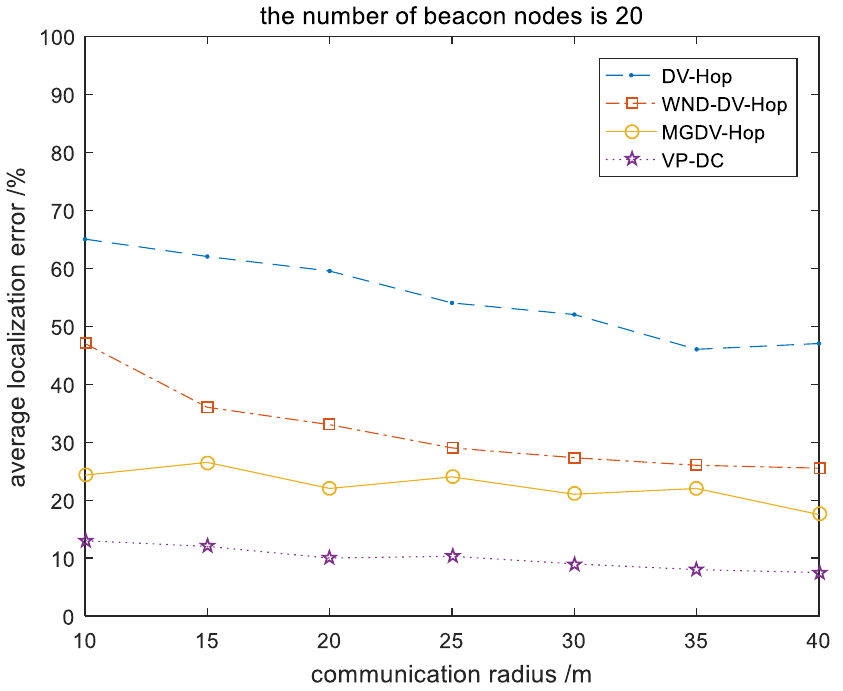
Figure 9. Relationship between nodes communication radius and average localization error.